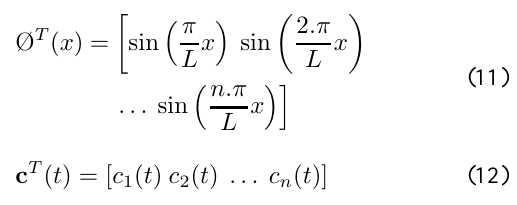
Fig. 6. Plot of fifth vibration mode